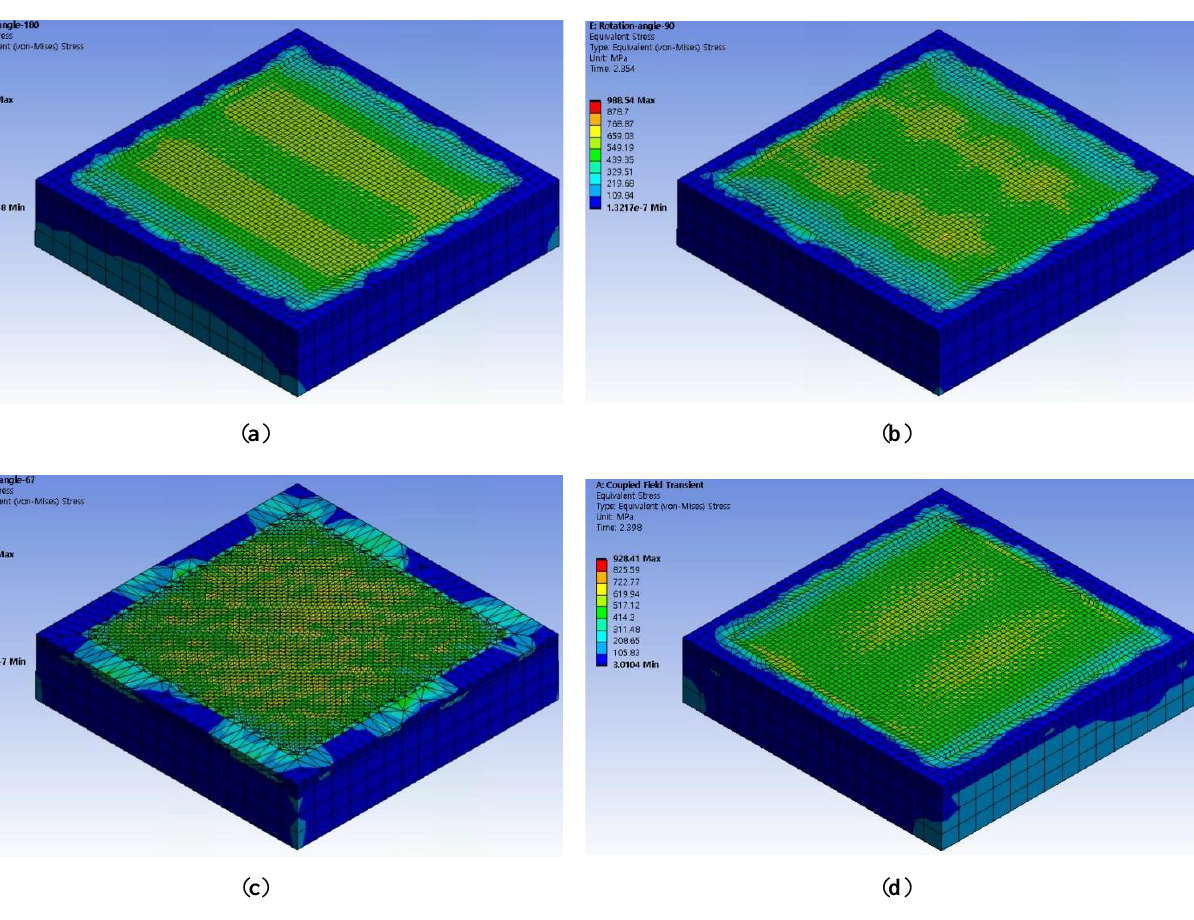
Figure 8. Residual stress simulation results according to pattern rotation at third layer additive process: ( a ) same direction (180°); ( b ) 90° rotation; ( c ) 67° rotation; ( d ) 45° rotation.